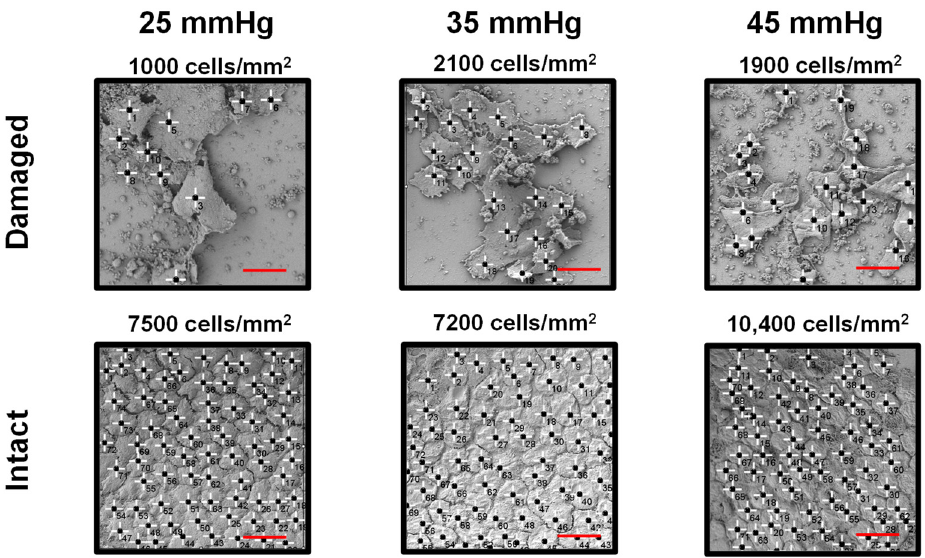
Figure 5. Representative SEM images of damaged and intact endothelial layers from all 3 groups. Each image is 100 by 100 microns. Markers show endothelial cells at the conclusion of the experiment. In the intact group, the endothelial tight junctions are evident. The cell density is estimated based on the number of cells signified by the markers in each ROI and is displayed above its corresponding ROI. The red scale bars are 20 microns in length.